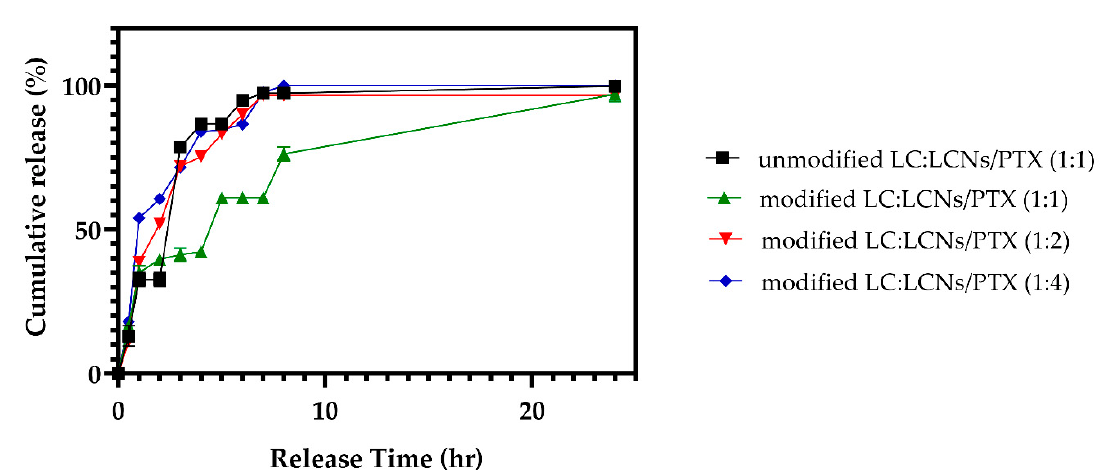
Figure 5. In vitro release profile of the PTX from unmodified hydrogels containing LCNs/PTX and modified hydrogels containing LCNs/PTX with different LC:LCNs/PTX ratios. Modified hydrogels containing lower concentrations of LCNs/PTX revealed a lower release rate compared to other samples.